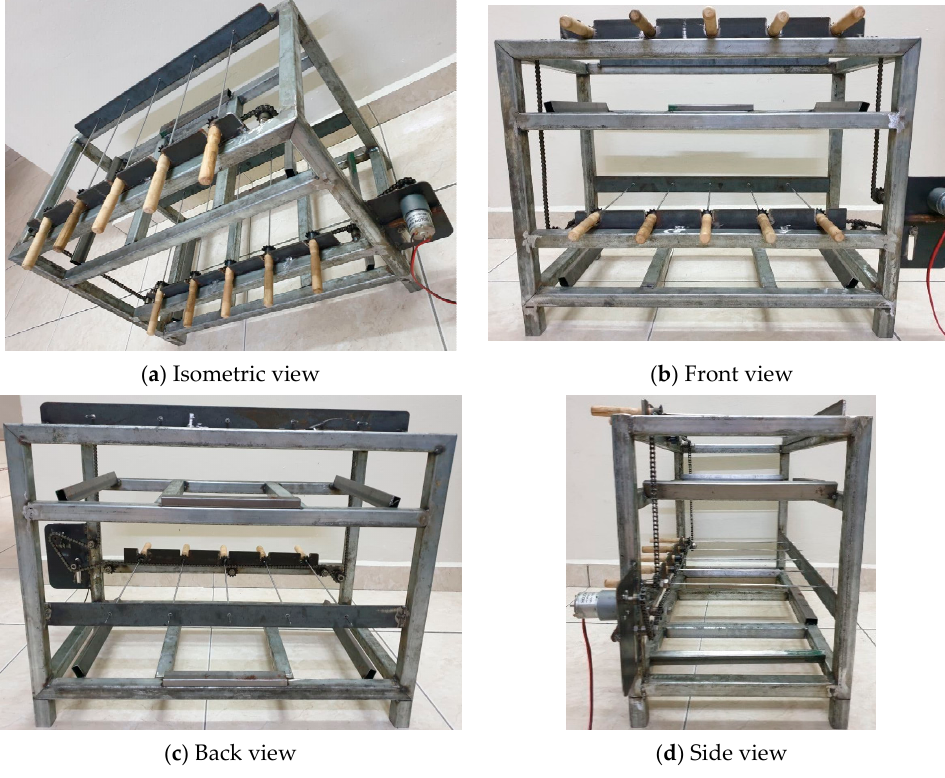
Figure 6. The finalised prototype.